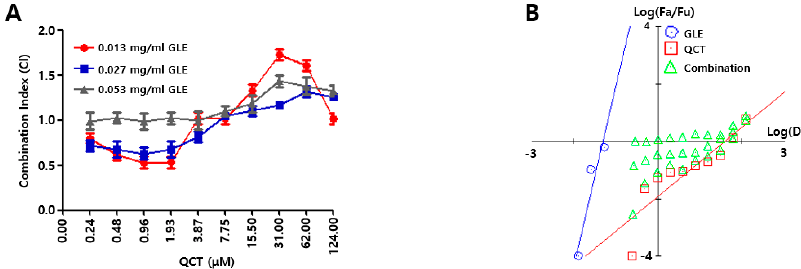
Figure 1. Synergism of GLE and QCT in causing cytotoxicity. The measurements of cytotoxic synergism of the combinations of GLE and QCT in SNU719 cells using Fa-CI plot ( A ) and the median-e ff ect plot ( B ). Combinations of GLE and QCT were made in a series of concentrations and applied to the CCK8. GLE, QCT and CI: Ganoderma lucidum extracts, quercetin and combination index, respectively.